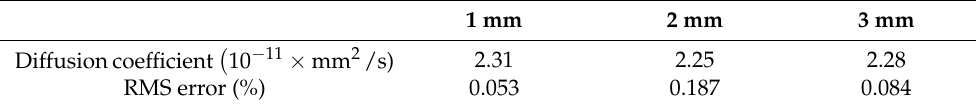
Figure 4. Sorption curves at 5 MPa and a temperature of 290 K. Table 1. Diffusion coefficient at 5 MPa and a temperature of 290